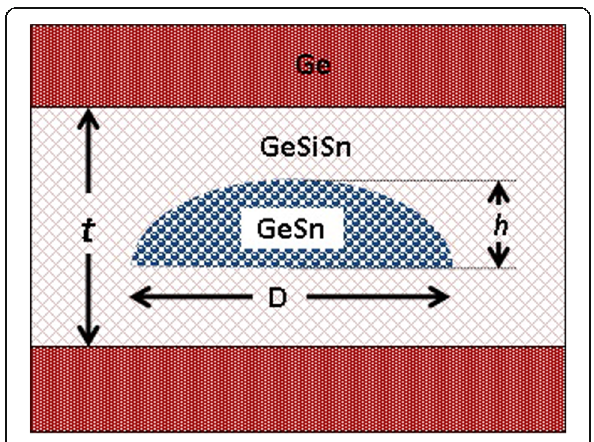
Fig. 2 Schematic presentation of the modeled GeSn QD of height ( h ) and diameter ( D ) within GeSiSn strain-reducing layer in Ge matrix